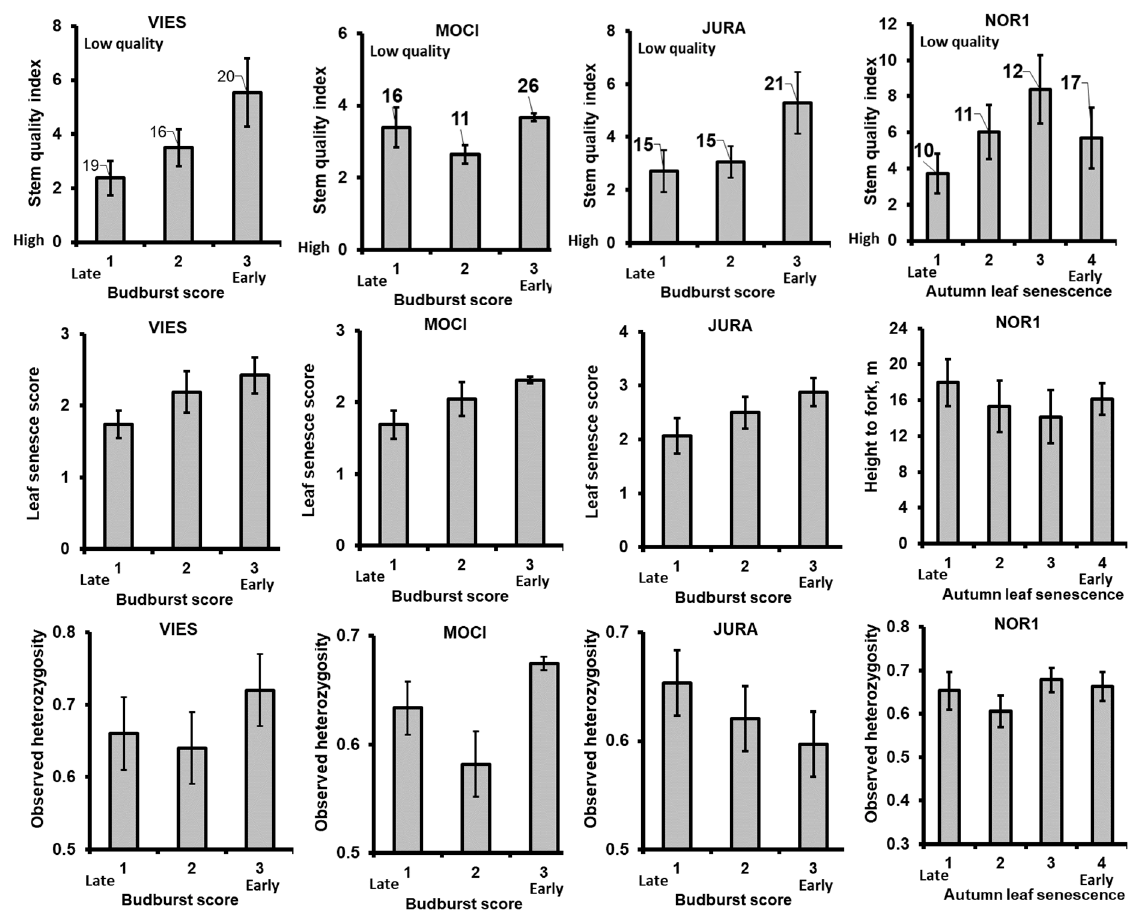
Figure 2. Associations between the budburst phenology, autumn leaf senescence, stem quality and observed heterozygosity in VIES. MOCI, JURA and NOR1 stands. The number of trees at a particular budburst stage is given above the bars at upmost row of the plots. The error bars indicate standard error. For NOR1, height to fork is given because budburst was not scored in NOR1.